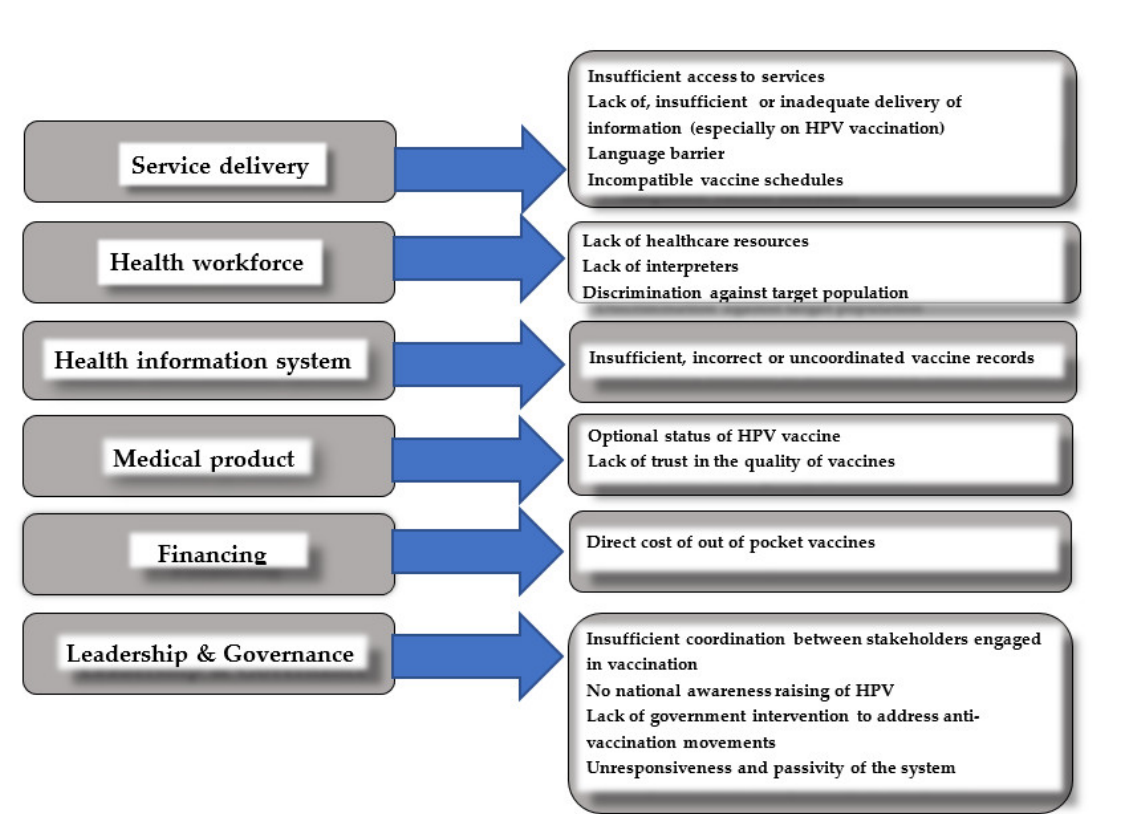
Figure 1. A summary of the barriers identified across UMs for each WHO health system building block